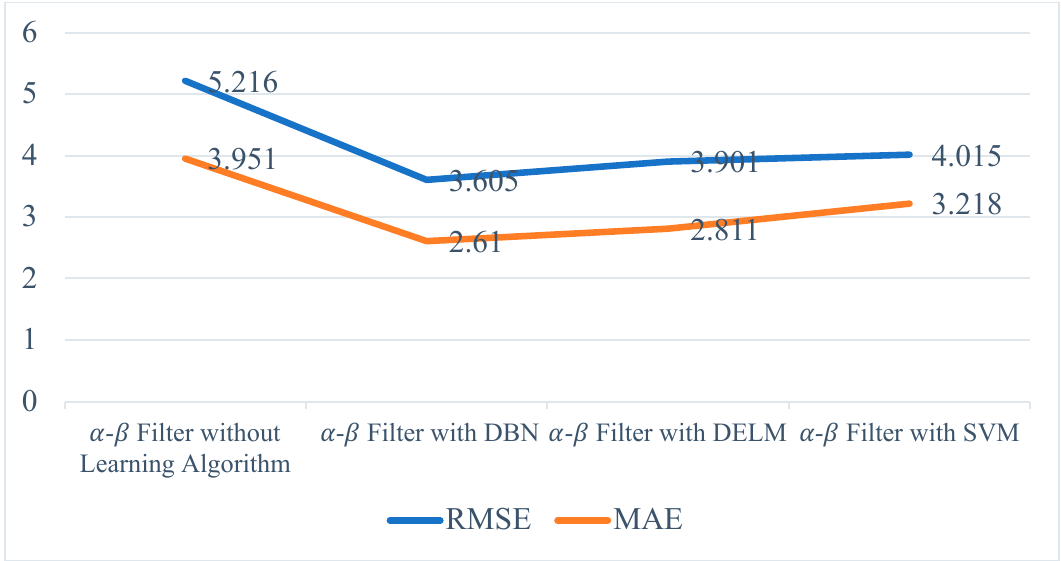
and MAE. and MAE.